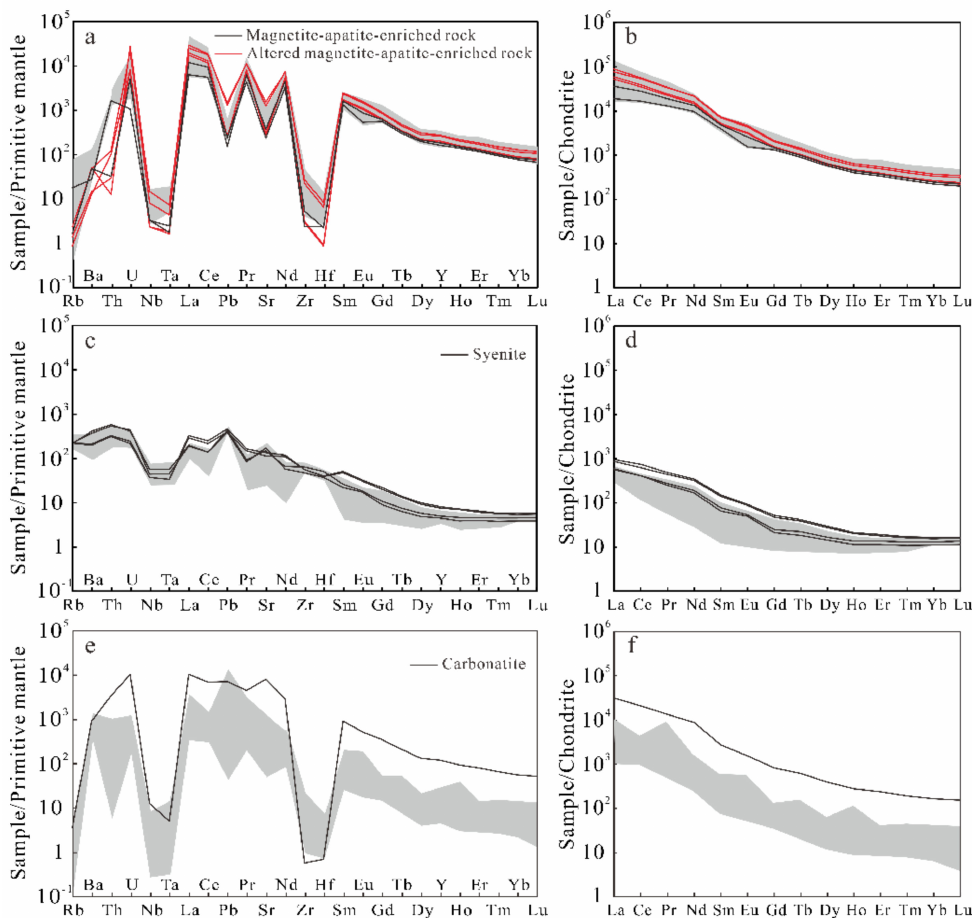
Figure 6. Primitive mantle normalized trace element and chondrite-normalized REE patterns of magnetite-apatite-enriched rocks ( a , b ), syenites ( c , d ), and carbonatites ( e , f ) from the Mushgai Khudag complex. Normalization values were adopted from McDonough and Sun [39] and Sun and Mc- Donough [40], respectively. Reported data for these rocks are presented as grey shades for compari- son [6,10,13]. Syenites contain 63.16–63.27 wt.% of SiO 2 and 11.80–11.56 wt.% of Na 2 O + K 2 O